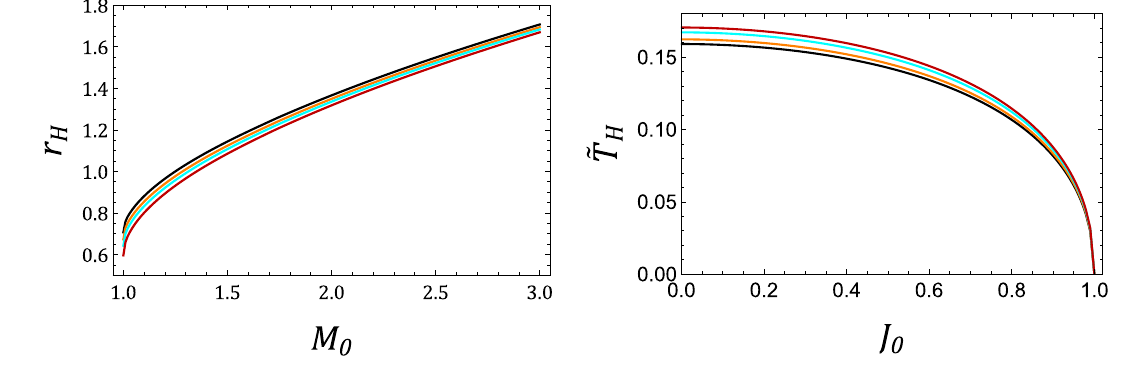
Fig. 6 Left panel: Black hole horizon, r H , against the classical black hole mass M 0 , for different values of the parameter ξ . We have assumed J 0 = 1 ,(cid:9) 0 = 1 and G 0 = 1. Right panel: Scaled Black hole temper- ature, ˜ T H , against the classical angular momentum parameter J 0 for different values of the parameter ξ . We have assumed M 0 = 1 ,(cid:9) 0 = 1